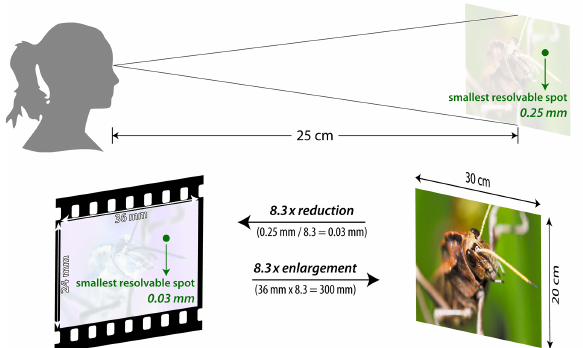
Figure 4. The commonly used (but outdated) CoC threshold of 0.03 mm is determined by human visual